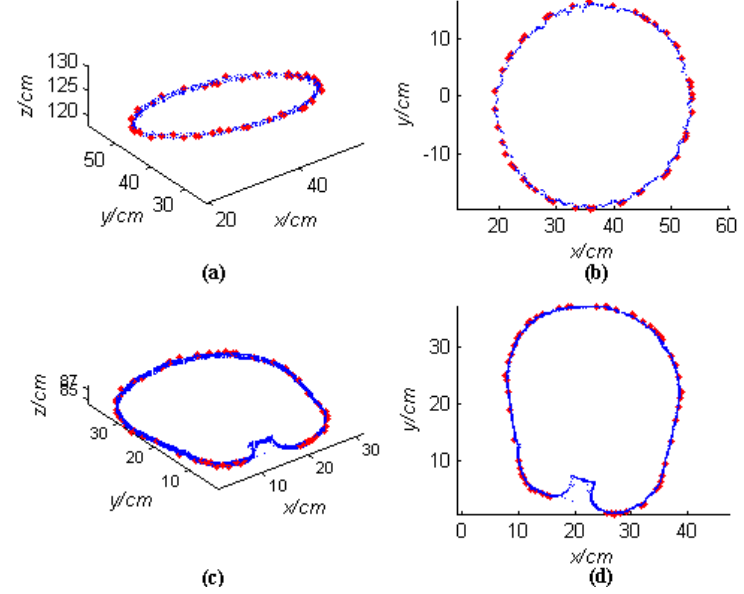
Figure 5. Stem cross-sectional points for the simulated path of the diameter tape. ( a ) Stem cross-sectional points of Tree 002; ( b ) planar projection point set of the stem cross-sectional points in ( a ); ( c ) stem cross-sectional points of Tree 003; ( d ) planar projection point set of the cross-sectional points in ( c ). The red points represent the convex hull points calculated from the planar projection point set.